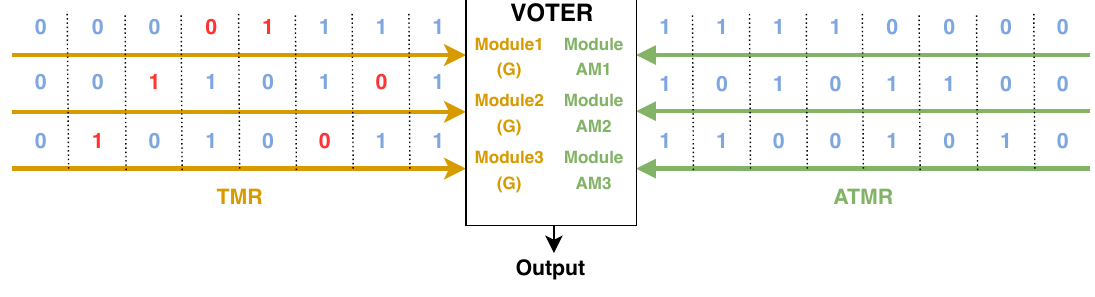
Figure 2. Input Vectors for